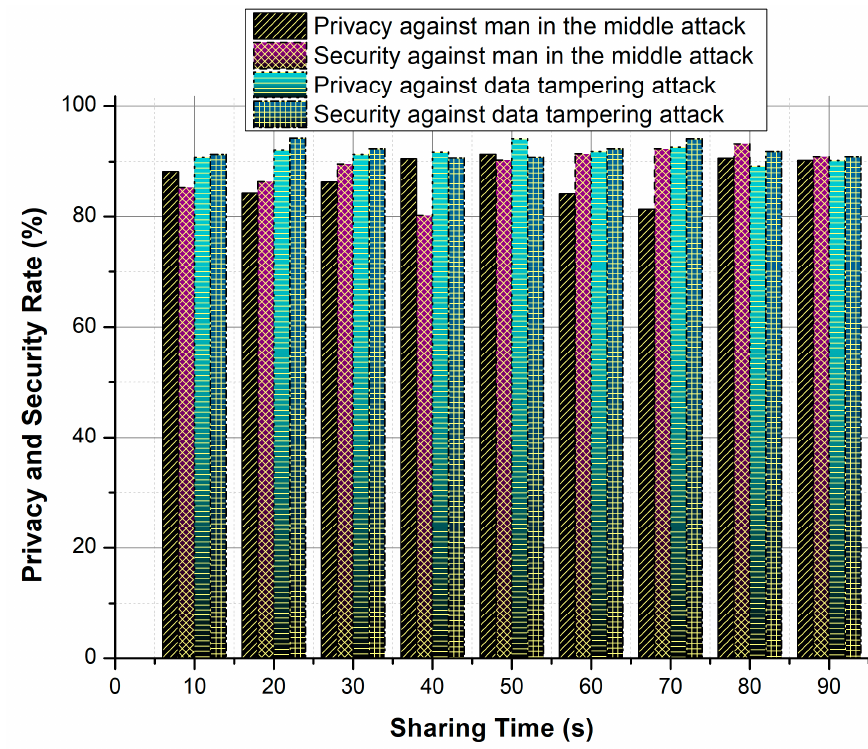
Figure 8. Privacy and security ratio against attacks.